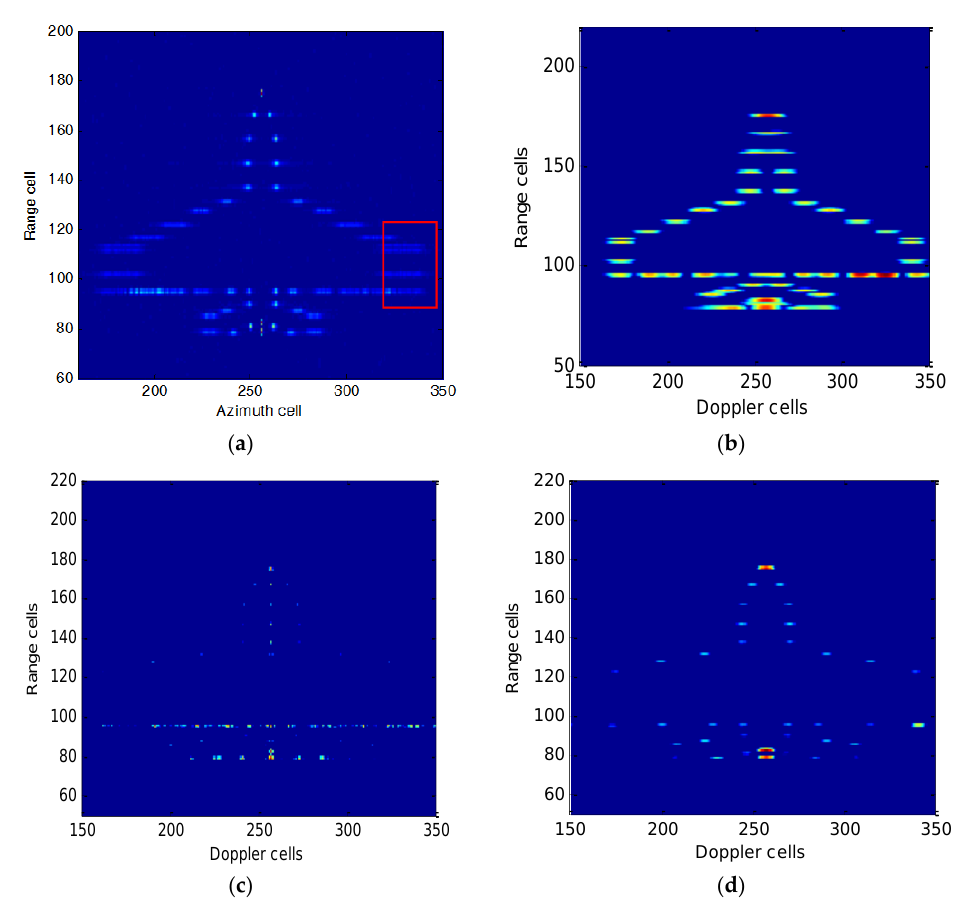
Figure 11. Azimuth compression via classical methods: ( a ) direct DFT, ( b ) RID image based on STFT, ( c ) RID image based on WVD and ( d ) RID image based on SPWVD.